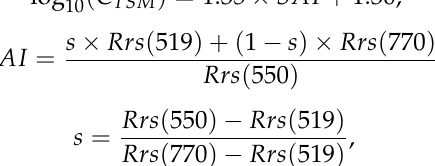
each band of GF-4 and GOCI satellites, the spectral response function was used to conduct GOCI satellite and GF-4 satellite was compared, and the root mean square error (RMSE)